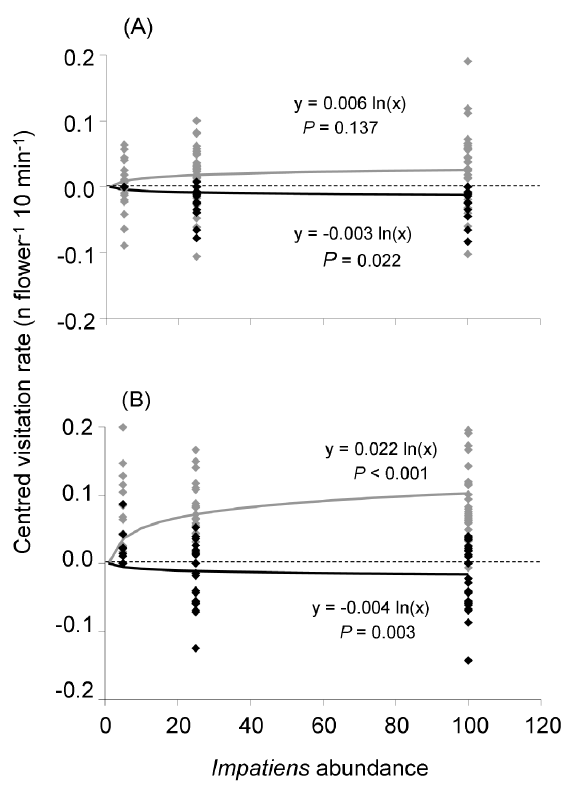
F IG . 3. Centred visitation rate in 2009 as a function of I. glandulifera abundance (5, 25 and 100 individuals) for both native plant species, (A) A. napellus and (B) E. angustifolium and for the two main pollinator categories (grey diamonds: bumblebees; black diamonds: honeybees). For both pollinator categories, model predictions are represented by a solid line and described by the equation with the corresponding P- value indicating